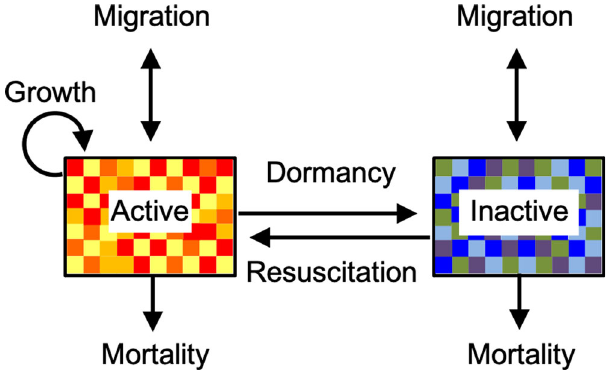
Fig. 2 Primary attributes (boxes) and transitions (arrows) in a generalized seed-bank model. In this example, the sizes of the active and dormant pools are made up of an equal number of individuals ( N = 70) belonging to different classes (colored squares), which may represent genotypes within a population or species within a community. In the active pool, individuals can be gained through reproduction and lost through mortality. In the dormant pool, there is no reproduction, and mortality of inactive individuals is typically assumed to be much lower than for active individuals, which is reasonable for many but not all taxa that invest in long- lived seed banks. In addition, pool sizes are in fl uenced by stochastic or deterministic transitions between metabolic states (i.e., initiation and resuscitation), which determine the size and rate at which pools undergo turnover. In terms of α -diversity, the richness of classes in the dormant pool (S = 9) is greater than the richness in the active pool ( S = 4). In terms of d a β -diversity, the active and inactive pools are 82 % dissimilar based on the (cid:1) x (cid:2) x abundance-weighted Bray-Curtis metric: ∑ S k ¼ ak dk 1 where x ak and x dk correspond to the abundance of class k in the active ( a ) and dormant ( d ) pools, respectively, and S is the number of classes contained in the pools. Seed-bank attributes can also be in fl uenced by migration, especially when dormancy facilitates the dispersal and colonization of individuals in a regional